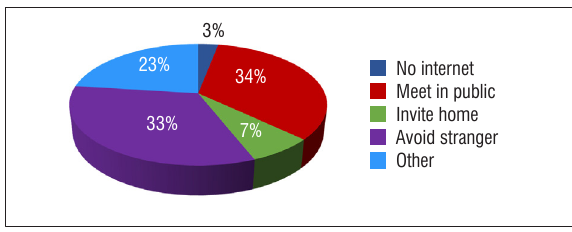
Willingness to meet with a stranger friended on